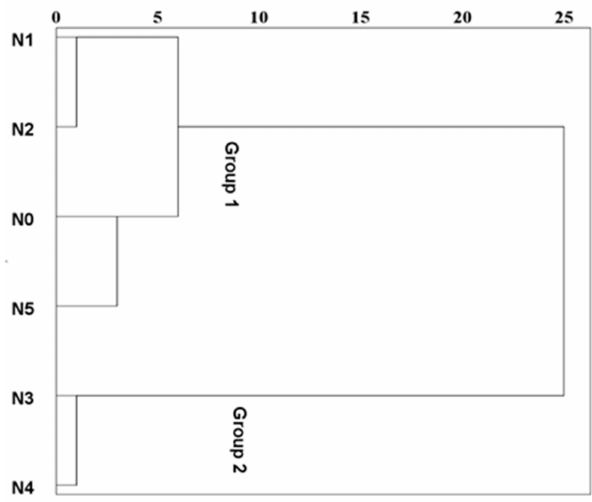
Figure 5. Cluster analysis of the influence of different N levels on leaf physiological